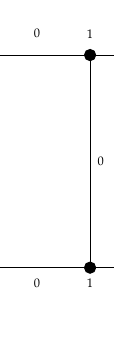
Figure 7. 3-TEMC labeling of L